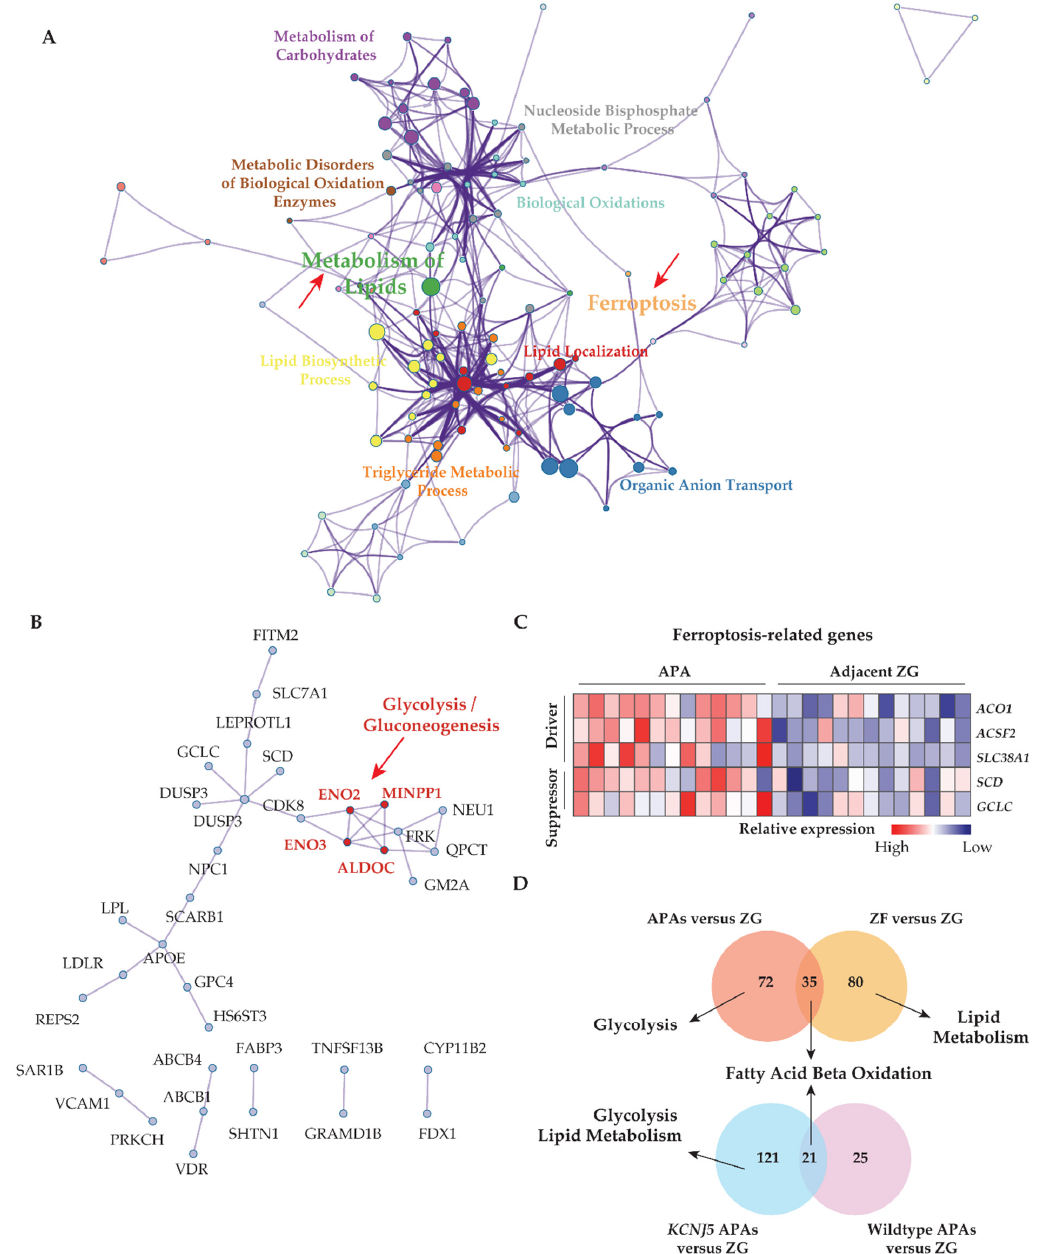
Figure 2. The interaction between lipid metabolism and ferroptosis, and the association of metabolic alterations with adjacent adrenal cortical tissue and APA genotype. ( A ) Metascape functional enrichment analysis of upregulated differentially expressed genes in APAs versus paired adjacent ZG (GSE64957). One node per enriched term, colored by cluster ID. Node size indicates the number of differentially expressed genes involved in the enriched term. ( B ) Protein–protein network using Molecular Complex Detection (MCODE) algorithm. Red fonts represent the core genes of the network involved in the glycolysis/gluconeogenesis pathway. ( C ) Heat map of ferroptosis-related upregulated differentially expressed genes grouped as driver and suppressor in APAs compared paired adjacent ZG. ( D ) Venn diagrams showing the number of unique and overlapping upregulated differentially expressed genes from APAs and adjacent ZF of those APAs to paired adjacent ZG comparisons, and from KCNJ5 mutated APAs and APAs without mutations (Wild type) to their adjacent ZG comparisons. Top pathways in which the distinct differentially expressed genes from APAs, adjacent ZF, KCNJ5 -mutated APA, and APA without mutations (Wild type), respectively compared to paired adjacent ZG, using g:profiler online tool. APA, aldosterone-producing adenoma. AAC, adjacent adrenal cortex; ZG, zona glomerulosa; ZF, zona fasciculata; DEGs, differentially expressed genes; NES, normalized enrichment score; FDR, false discovery